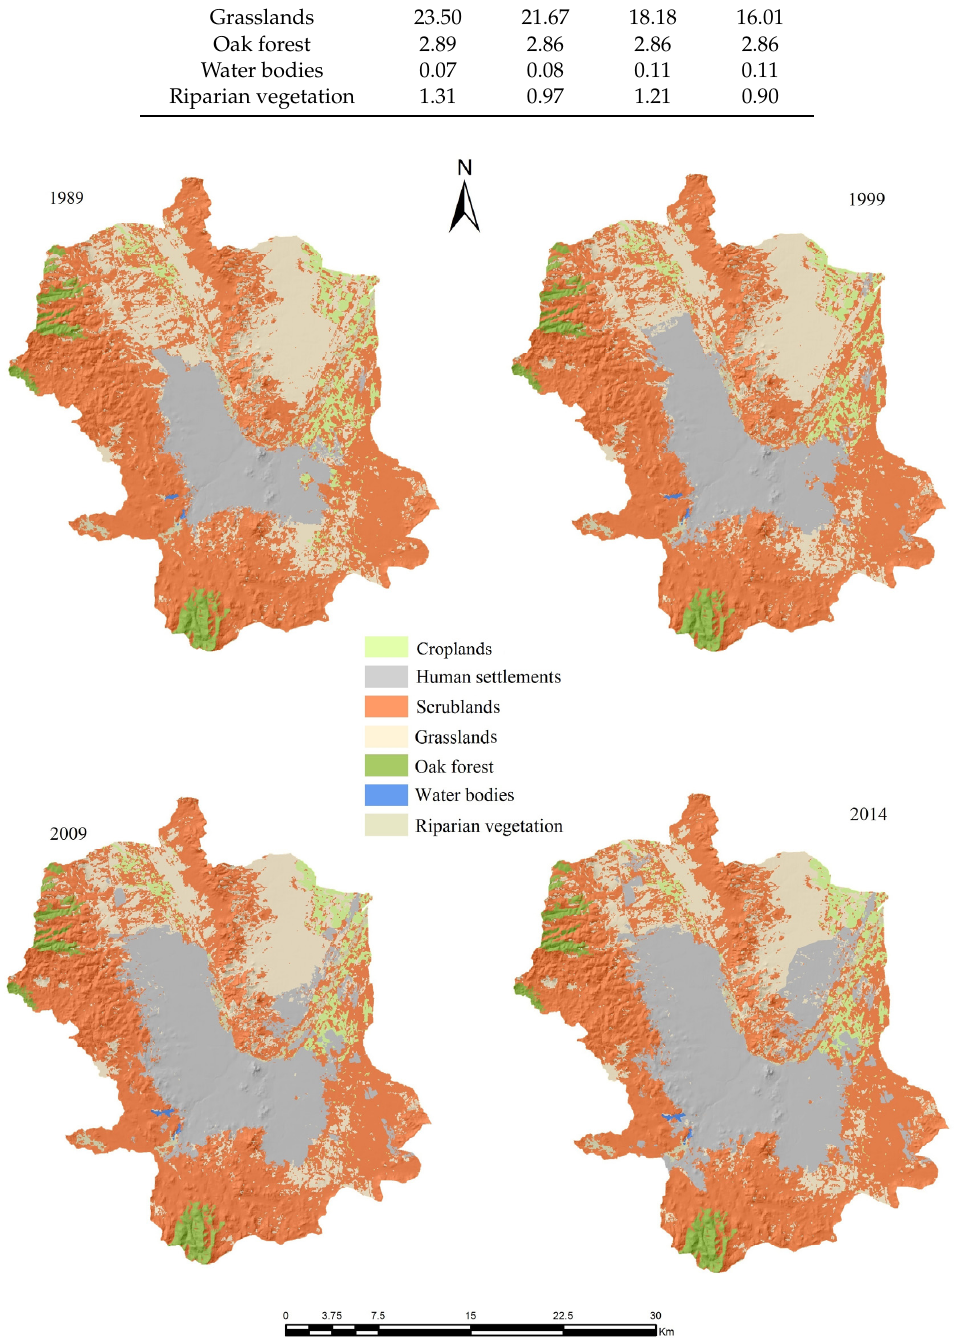
Figure 6. Land use maps of the city of Chihuahua for the years 1989, 1999, 2009 and 2014.